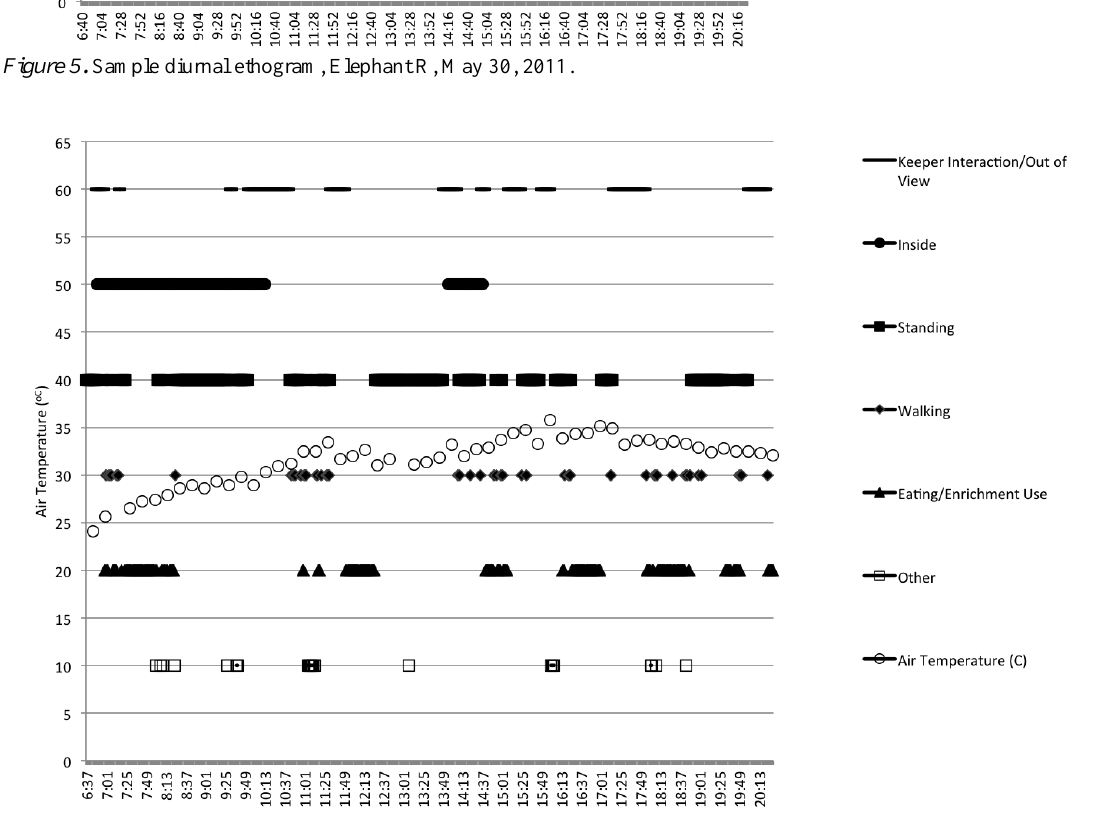
Figure 6. Sample diurnal ethogram, Elephant R, June 11,